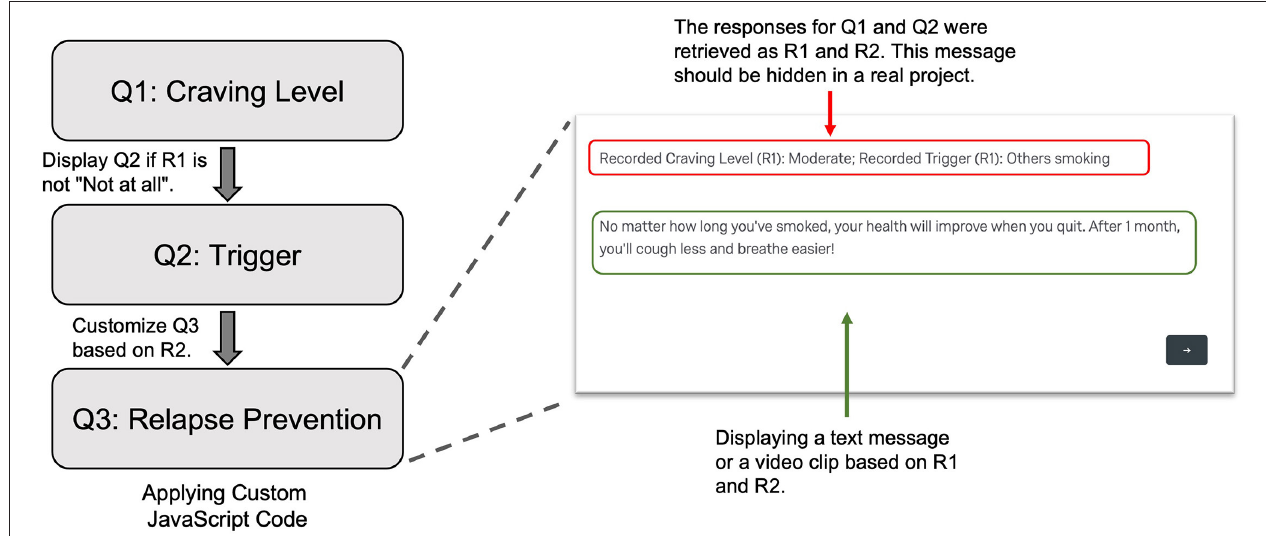
FIGURE 4 | Display a text message or video clip as a relapse prevention strategy in the subject-initiated EMA. Q1 was the question assessing current craving level. When the subject reported a carving level other than “Not at all,” Q2 was displayed to access the primary trigger. In Q3, using custom JavaScript code, we retrieved